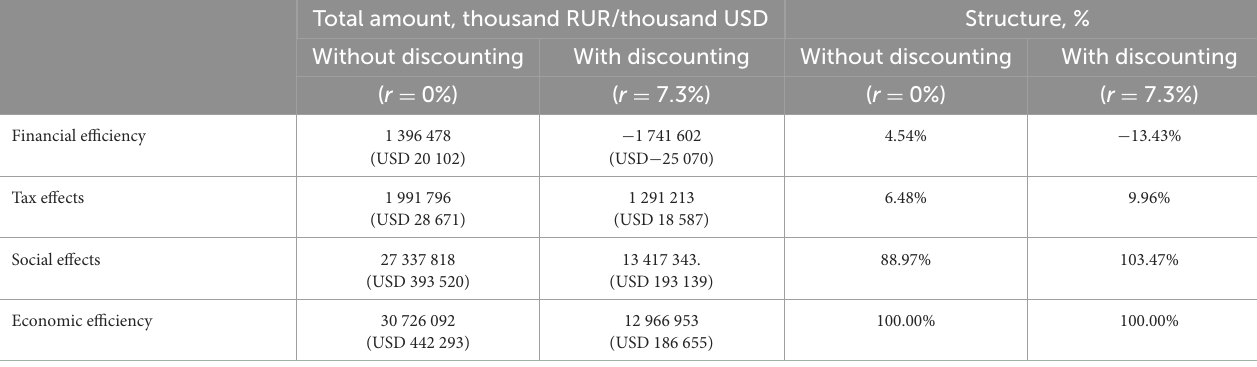
TABLE 5 The main effect for the outpatient clinics’ project for the period 2019–2035.